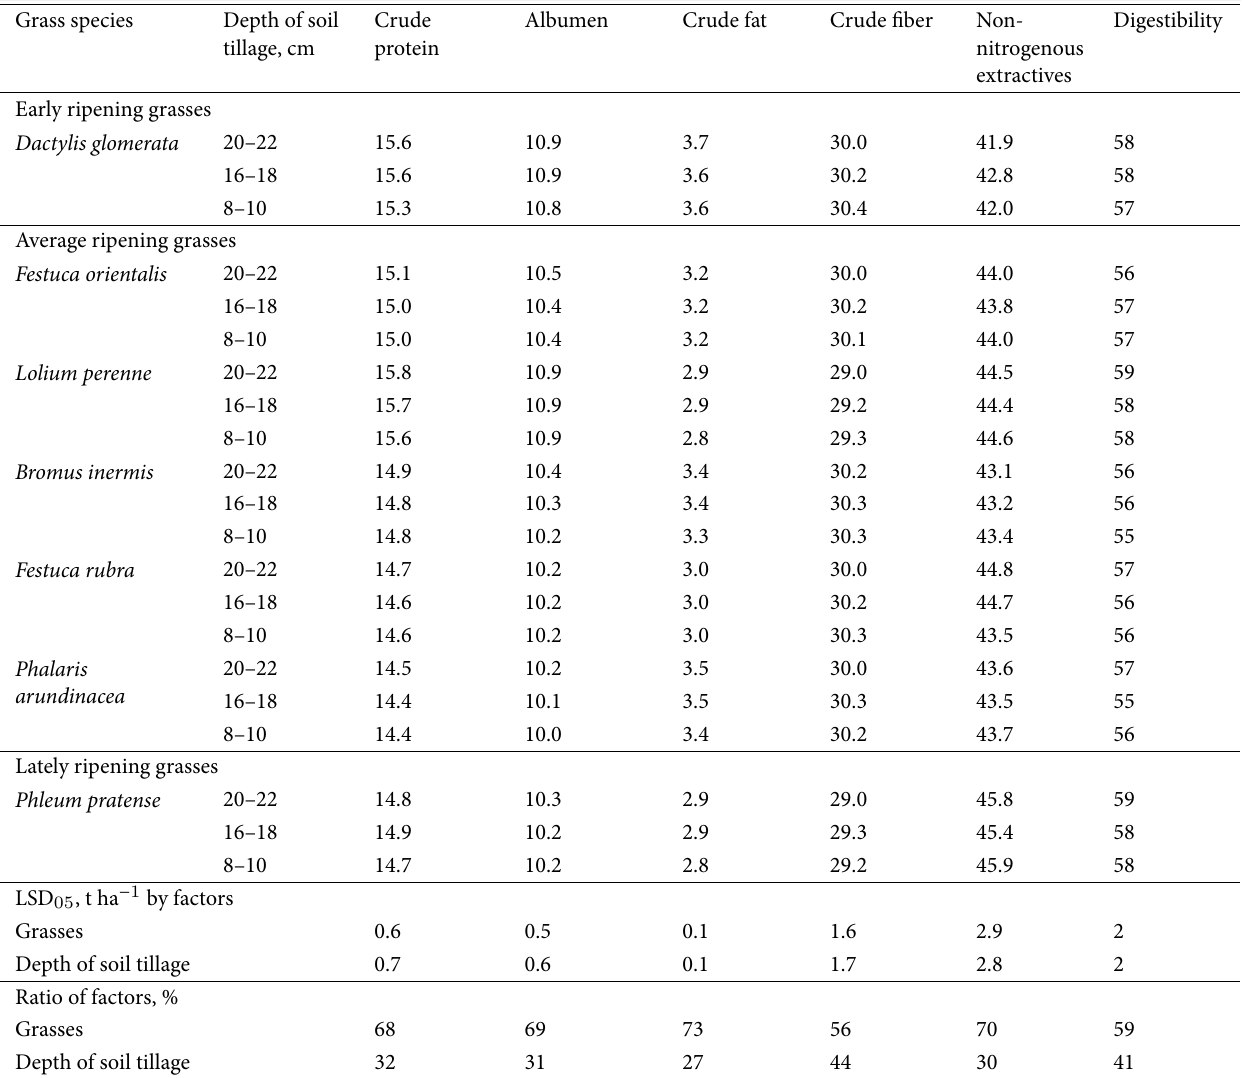
Table 3 Average content of organic matter in fodder and digestibility of pasture grasses depending on the depth of main soil tillage, % in dry mass, from 2011 to